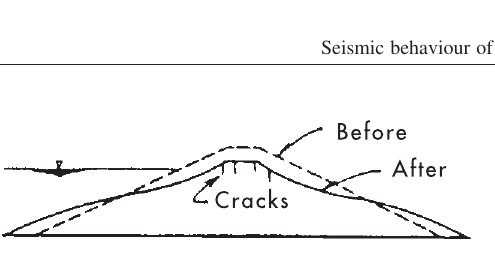
Fig. 5. Typical earthquake-induced damages to earth